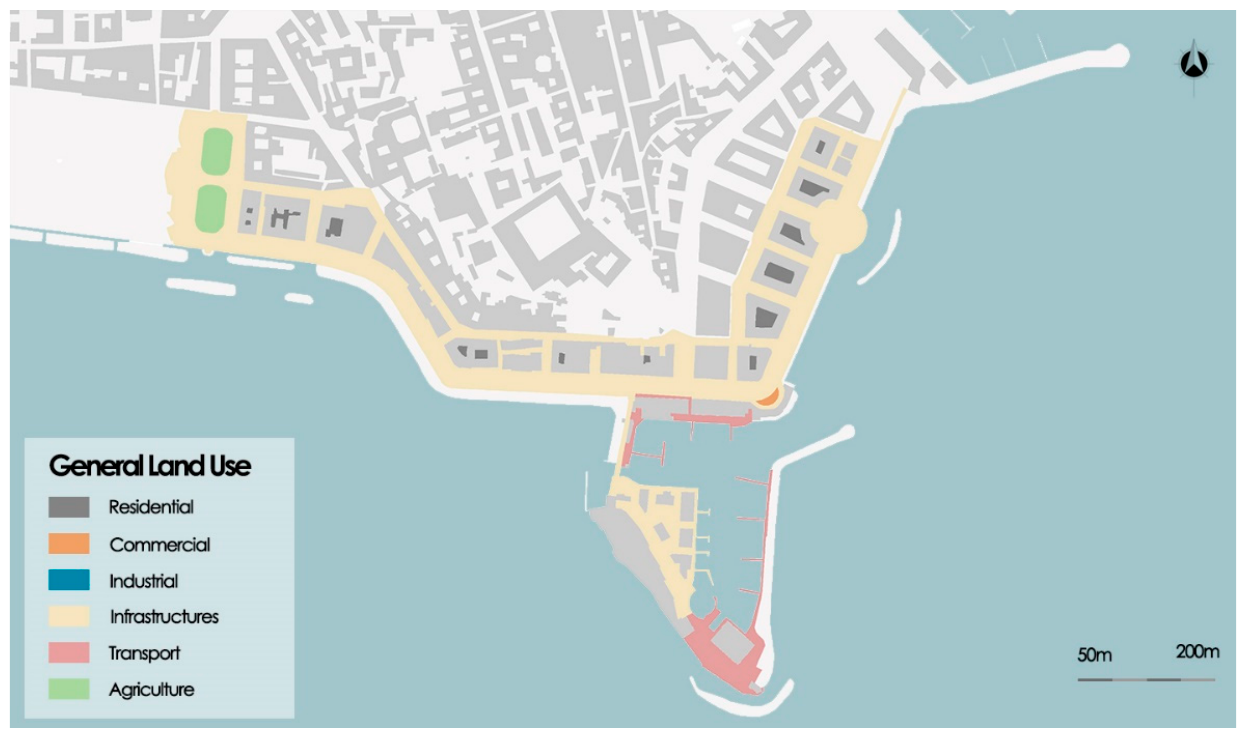
Figure 6. Distribution of the General Land Use on the study area (Naples, IT). The maximum potential exposed values were calculated on each atomic unit through a tabular joint that allowed for the correspondence between the potential economic damages defined by the global depth-damage functions and the GLU classes. According to the EU JRC depth-damage functions [43], to each GLU class was assigned the corresponding maximum economic damage € /sqm, based on the Italian national averages (Table